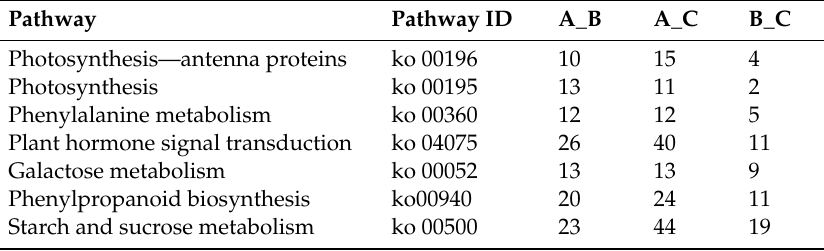
Table 4. DEG statistics in seven major pathways of Camellia oleifera